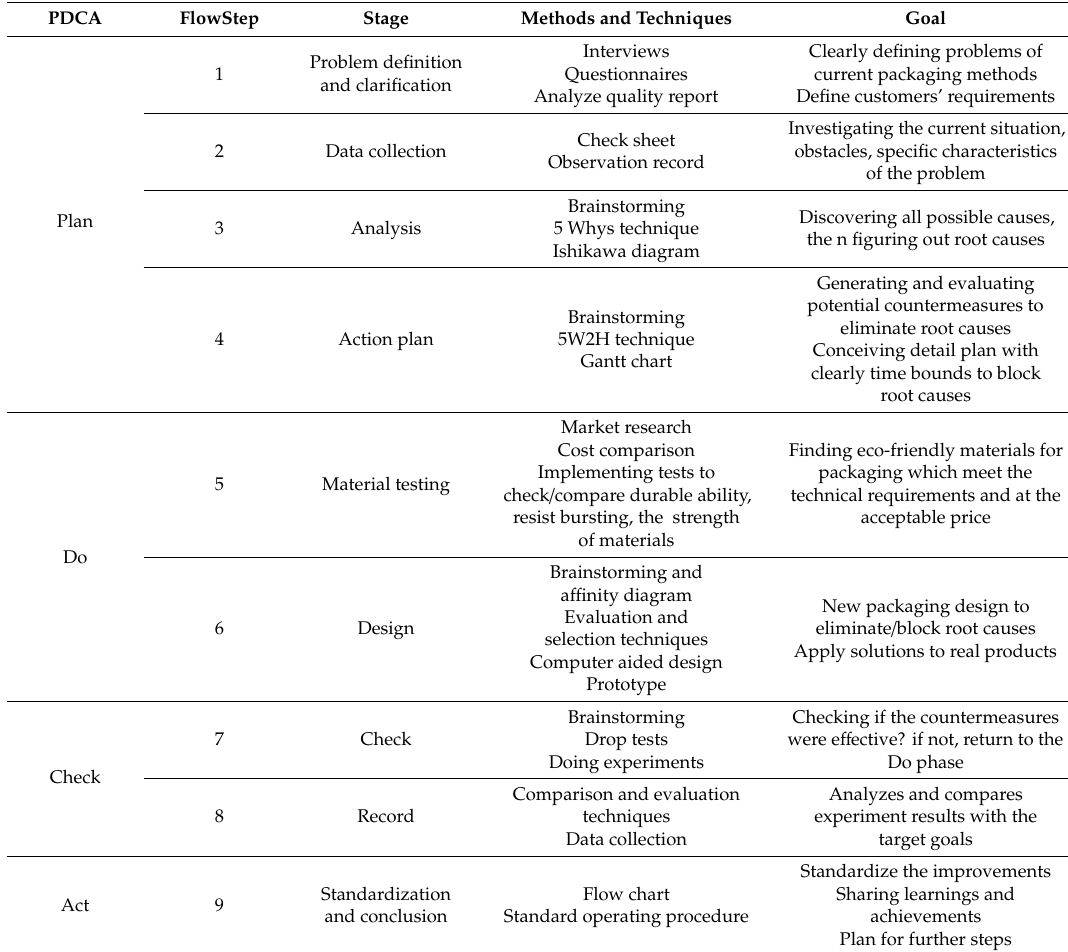
Table 1. Research